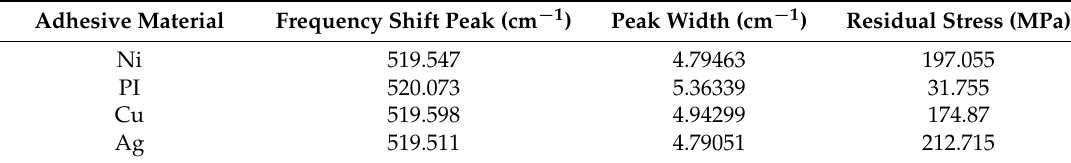
Table 7 . Raman spectral peak results and the surface residual stress of the MEMS S&A device for Ni, Cu and Ag metal films and polyimide (PI) film.